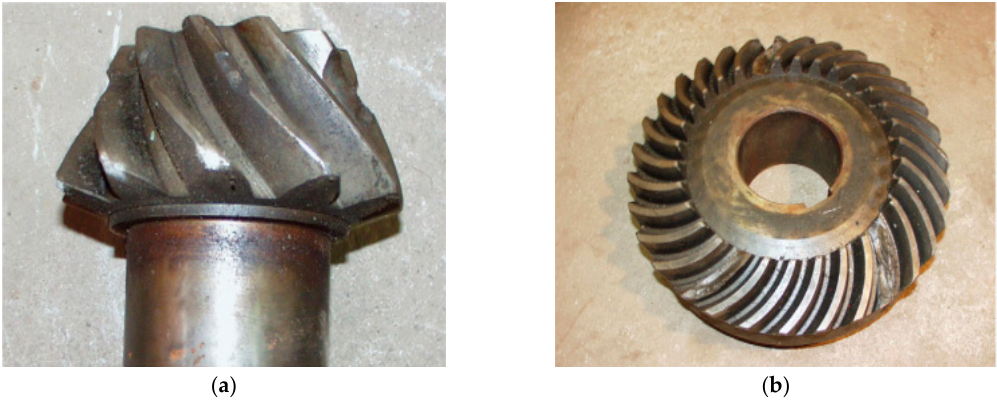
Figure 16. The worn gear in fan gearbox: ( a ) the worn gear 1; ( b ) the worn gear 2.